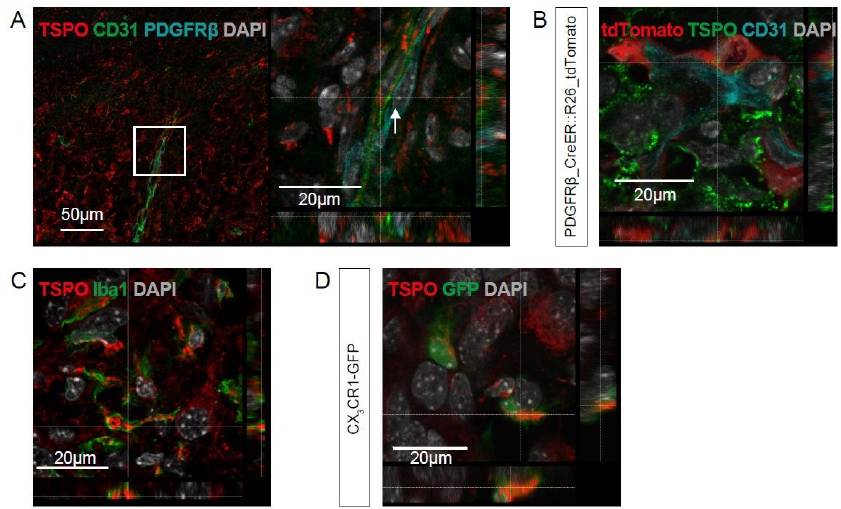
Figure 3. TSPO is expressed in tumor endothelia, pericytes, and myeloid cells. ( A ) Gl261 tumors grown for 3 weeks were co-stained by immunofluorescence for-anti-TSPO- (red), anti-CD31- (green), and anti-PDGFRB-antibodies (cyan) showing TSPO expression (red) in endothelia (green) and pericytes (cyan). ( B ) From Gl261 implants of PDGFRB::CreERT2,R26-tdTomato (red), mice immunofluorescent co-staining was performed using anti-CD31 (cyan) and TSPO (green), demonstrating the co-expression of TSPO in tdTomato-expressing pericytes (red). ( C ) Fluorescence staining with anti-Iba1 (green) and anti-TSPO (red) antibodies shows co-expression in tumor-associated myeloid cells. ( D ) TSPO immunofluorescence in the GL261 implant in CX3CR1-GFP mice confirms the co-expression of TSPO (red) in GFP (green)-positive microglia. ( A – D ) DAPI nuclear counterstaining is shown in gray; scale-size is indicated in the individual micrographs.